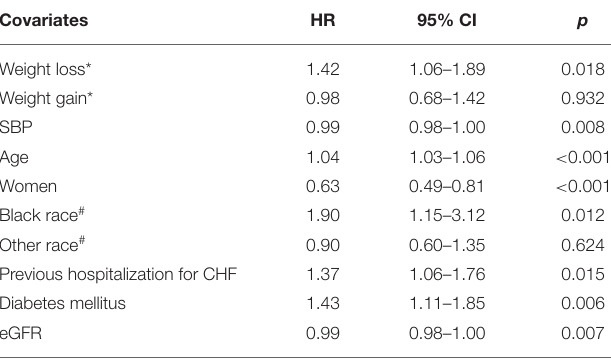
TABLE 2 | Multivariable Cox regression analysis for all-cause mortality.